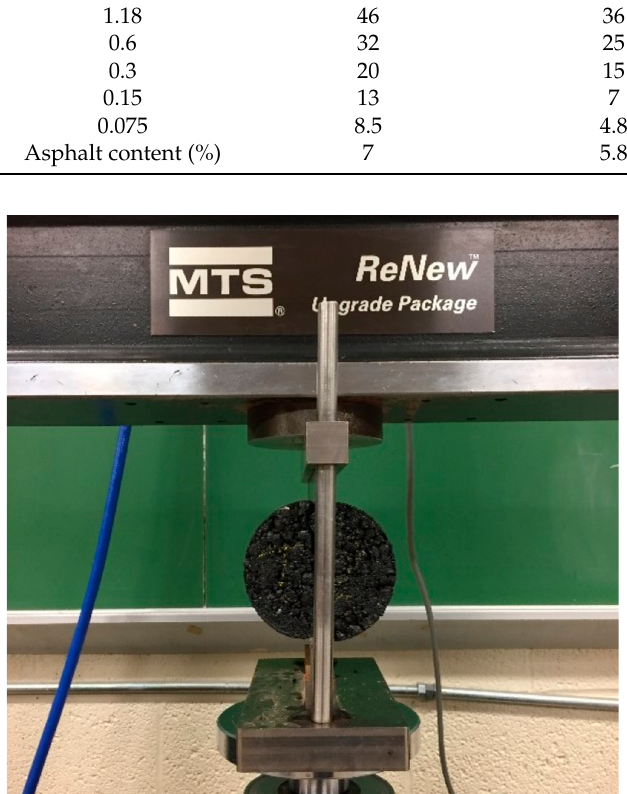
Figure 13. Indirect tensile strength test of asphalt mixture. Table 1. Mixture Design for Parameter Validation Tests.